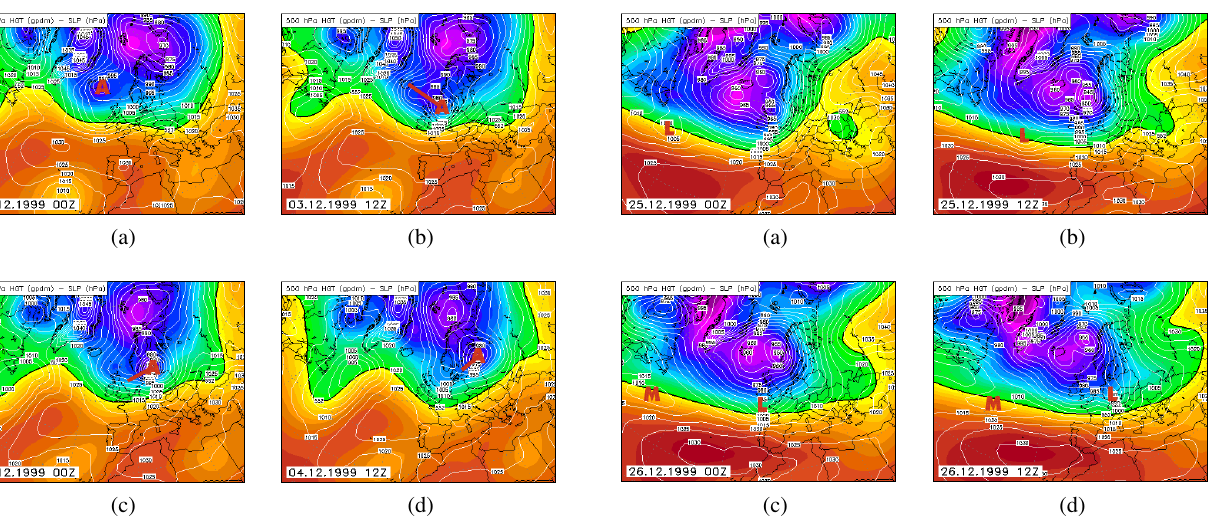
found on 2 December 06z until 5 December 06Z are given in Ta-